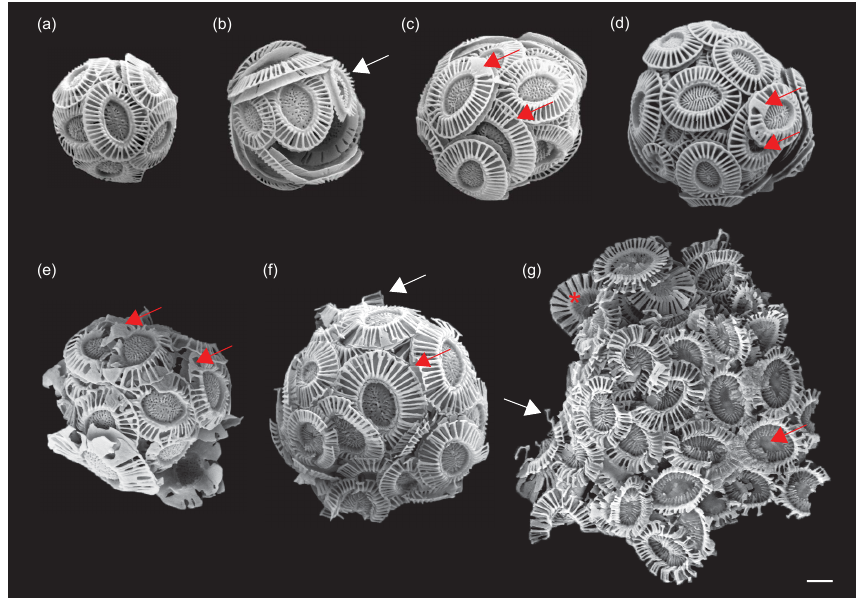
Figure 2. Representative SEM micrographs of normal, incomplete and malformed coccoliths, including dissolution features: (a) coccosphere bearing normal coccoliths; (b) arrow: an incomplete coccolith in control batch culture; (c) arrows: malformed coccoliths with merged distal shield elements/increased gaps; (d) a coccosphere from an Oslo Fjord field sample; arrows highlight the same type of malformations (merged distal shield elements, missing central area) as observed in culture; (e) coccosphere with many malformed coccoliths showing merged distal shield elements, triangular thickening of the elements and irregular calcite growth; (f) partially dissolved coccosphere; white arrow: detached distal shield elements; red arrow: “hammer-like” distal shield elements; (g) strongly dissolved coccosphere; white arrow: detached distal shield elements; red arrow: dissolved central area; asterisk: exposed proximal shield elements. Scale bar = 1µm.